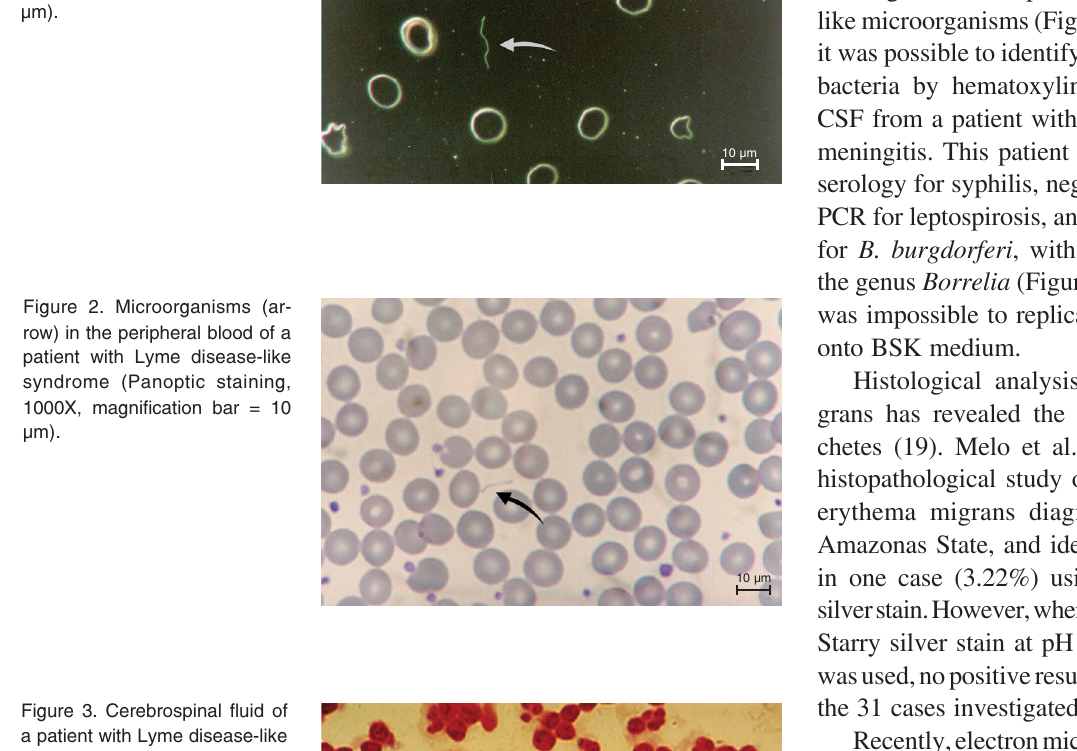
nm.Figure 1. Microorganisms (ar- row) visualized in patients with Lyme disease-like syndrome in Brazil (Dark-field microscope, 1000X, magnification bar = 10 µm).